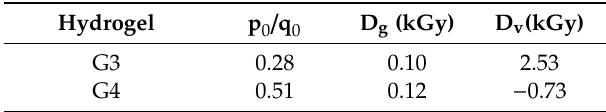
Table 1. Degradation vs. cross-linking ratio, gelation dose and virtual dose of hydrogels calculated according to the Charlesby–Rosiak